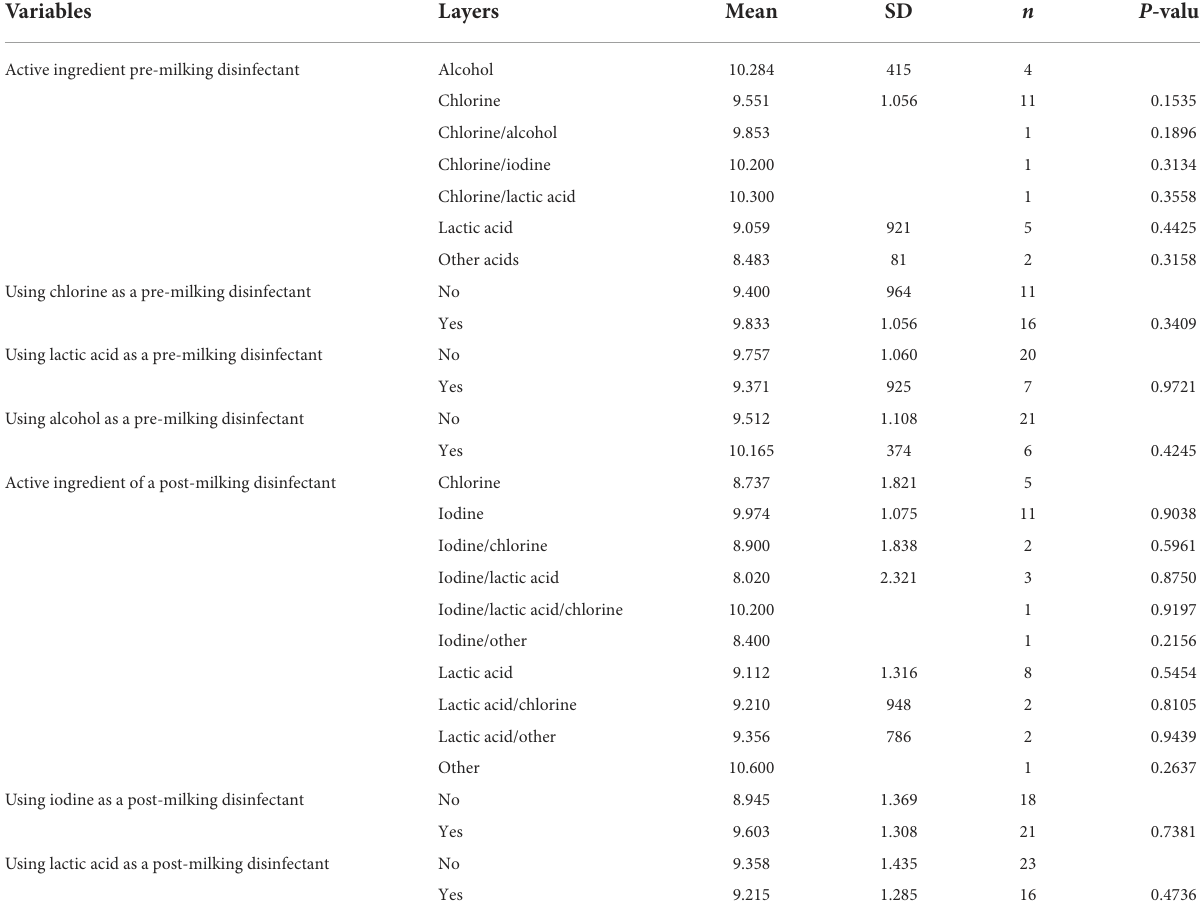
TABLE 4 Relationships between lactation milk yield (kg) and pre- and post-milking disinfectants. Variables Layers Mean SD n P -value Active ingredient pre-milking